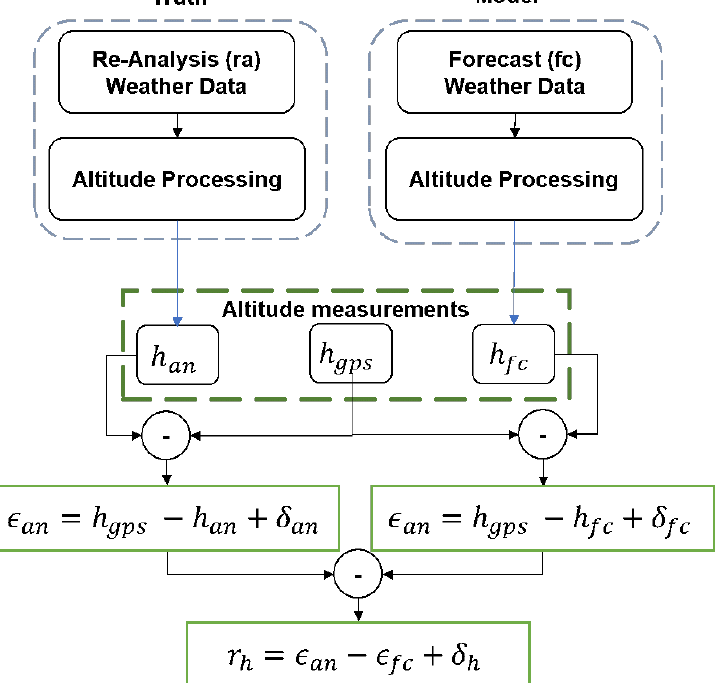
Figure 8. Computational setup for validating the accuracy of barometric altitude corrections using forecast numerical weather